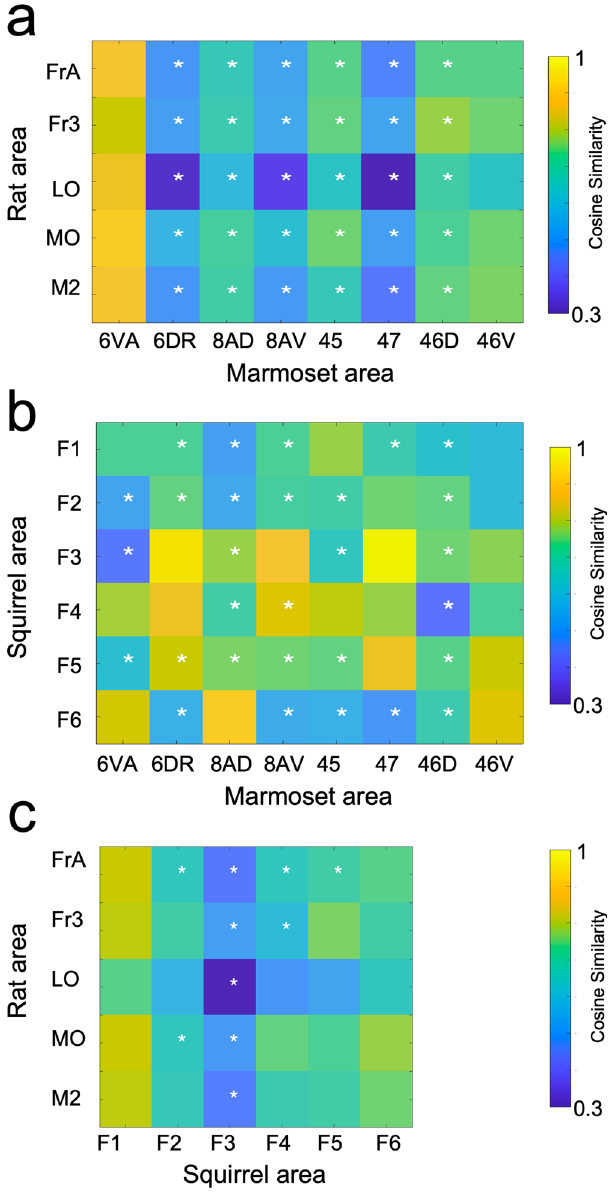
Fig. 3 Similarity of interareal functional connectivity patterns between the species. a Comparison of interareal functional connectivity patterns between rats and marmosets. For each species, cosine similarity values are plotted in matrix form. A high cosine similarity value suggests that the connectivity values are more comparable than a lower cosine similarity value. Signi fi cant differences are marked by a white asterisk within the similarity matrix. b Same as ( a ), but for comparing squirrels with marmosets. c Same as ( a ), but for comparing rats with squirrels. Seed region abbreviations: Frontal association cortex (FrA); lateral orbital cortex (LO); medial orbital cortex (MO); frontal cortex, area 3 (Fr3); secondary motor cortex (M2); frontal areas 1 – 6 (F1 – F6); area 6 of cortex, ventral, part a (6 VA); area 6 of cortex, dorsorostral part (6DR); area 8a or cortex, dorsal part (8AD); area 8a of cortex, ventral part (8AV); area 45 of cortex; area 47 of cortex; area 46 of cortex, dorsal part (46D); area 46 of cortex, ventral part (46 V). awake marmoset. This fi nding supports the notion that frontal areas in rats resemble primate premotor but not the prefrontal cortex (Fig. 3a; also see ref. 25).